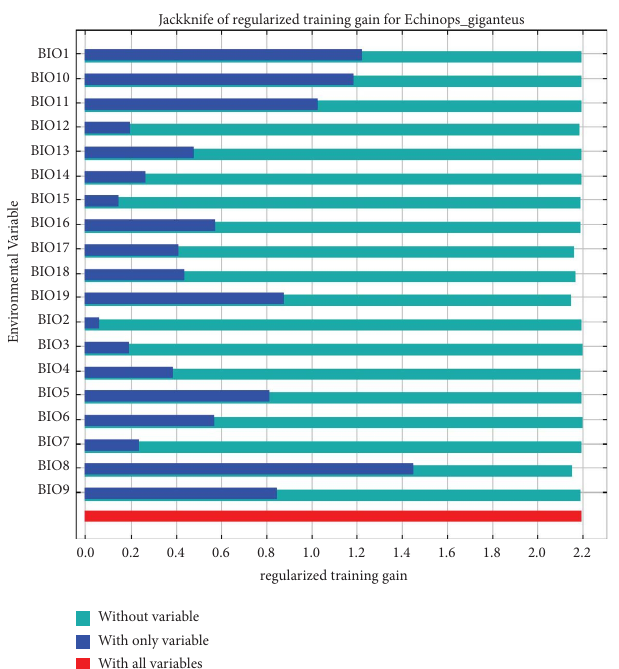
Figure 3: Statistical result of the jackknife test.